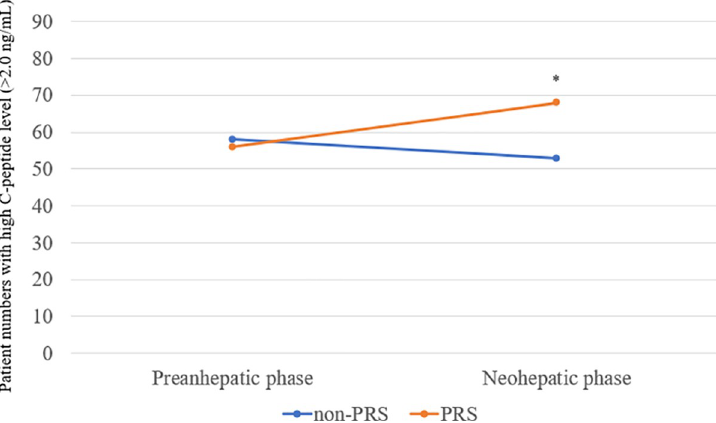
Fig 2. Comparison of occurrence of a high level of connecting peptide ( > 2.0 ng/mL) between propensity score- matched patients with or without postreperfusion syndrome (PRS). � p < 0.05.